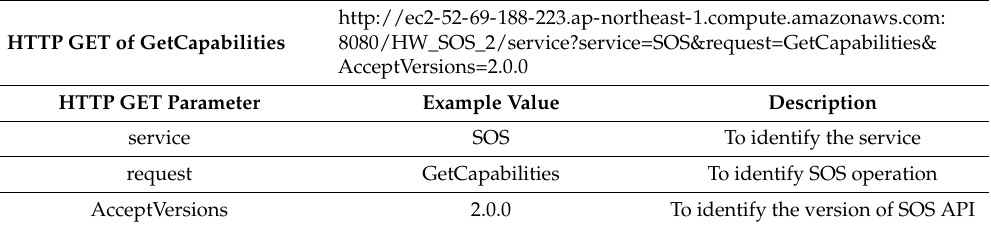
Table 1. HW SOS and GetCapabilities request.